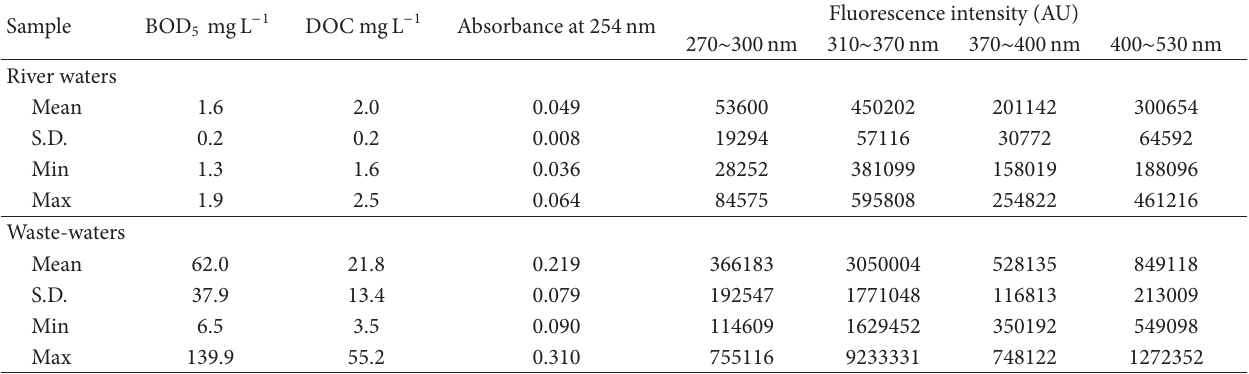
T 1: BOD 5 and different parameters measured for river waters and wastewaters.